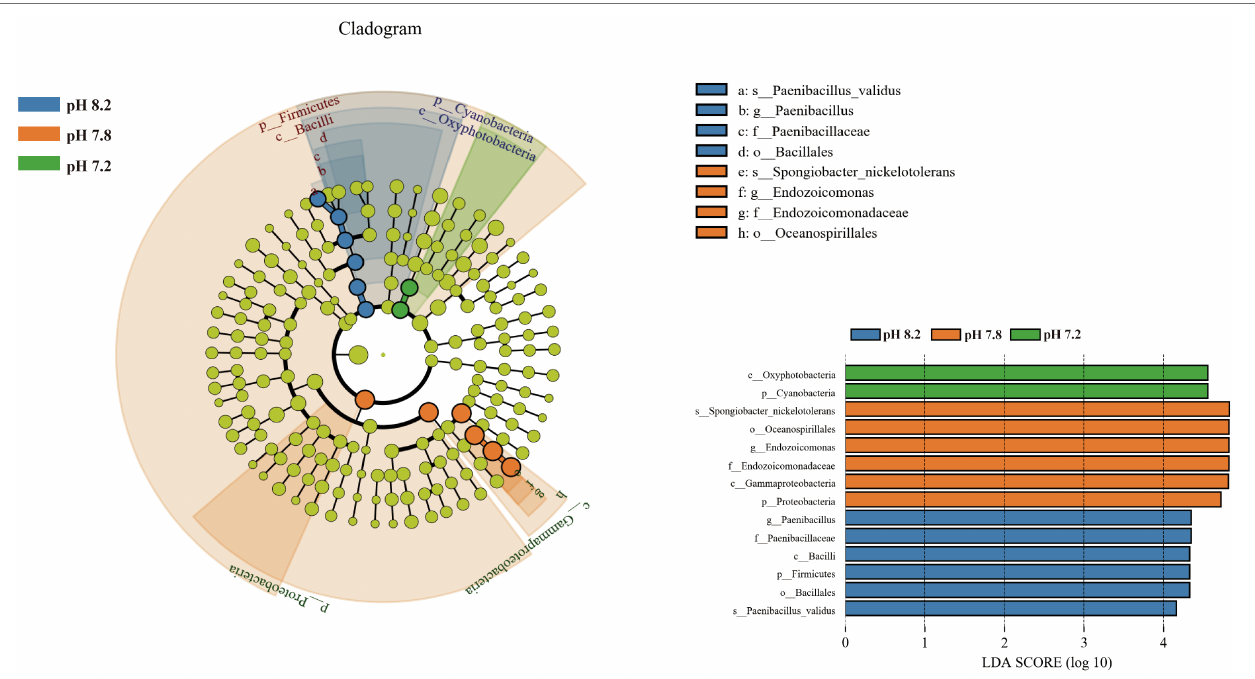
FIGURE 6 | Bacterial communities with statistically significant differences. Cladogram displaying the different microbiota structures from phylum to genus level. Linear discriminant analysis score > 4. Different-colored regions represent different constituents (blue, pH 8.2; orange, pH 7.8; green, pH 7.2; and yellow: nonsignificant). The diameter of each circle is proportional to the abundance of the